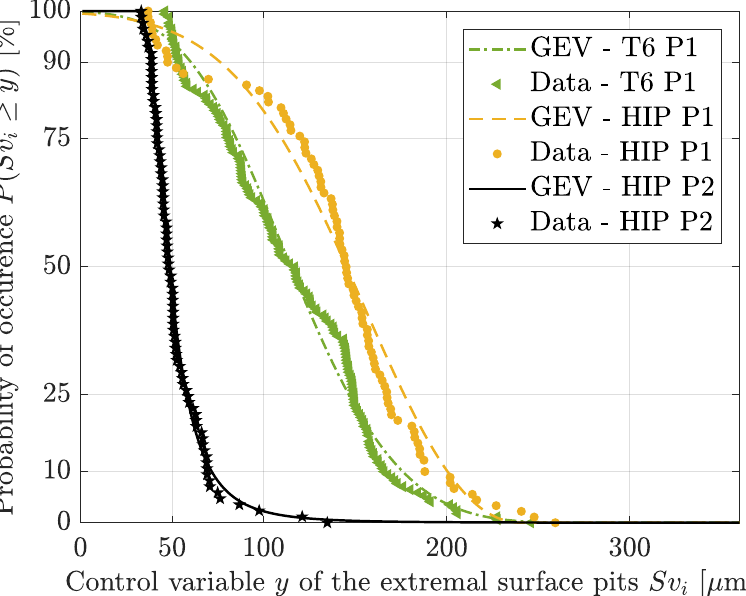
Figure 13. Visualisation of the function P ( Sv i ≥ y ) of the Sv i GEV